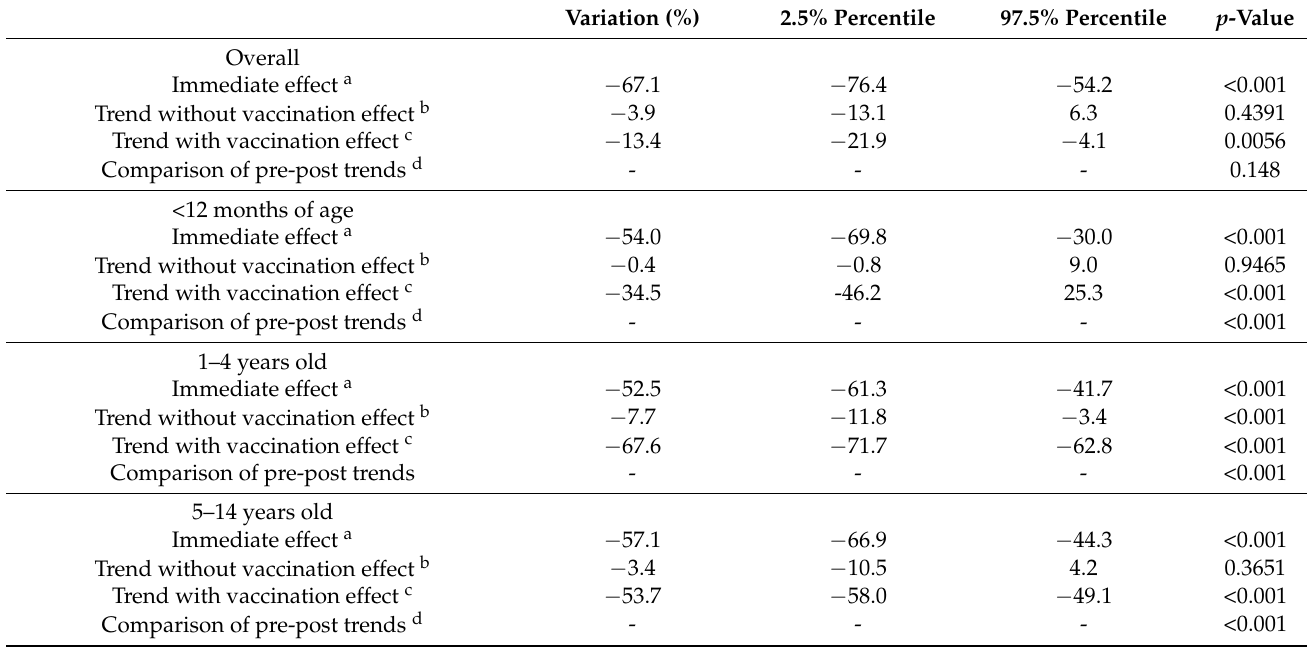
Table 2. Time-series model estimates of the impact of hepatitis A vaccination on yearly cases number, by age